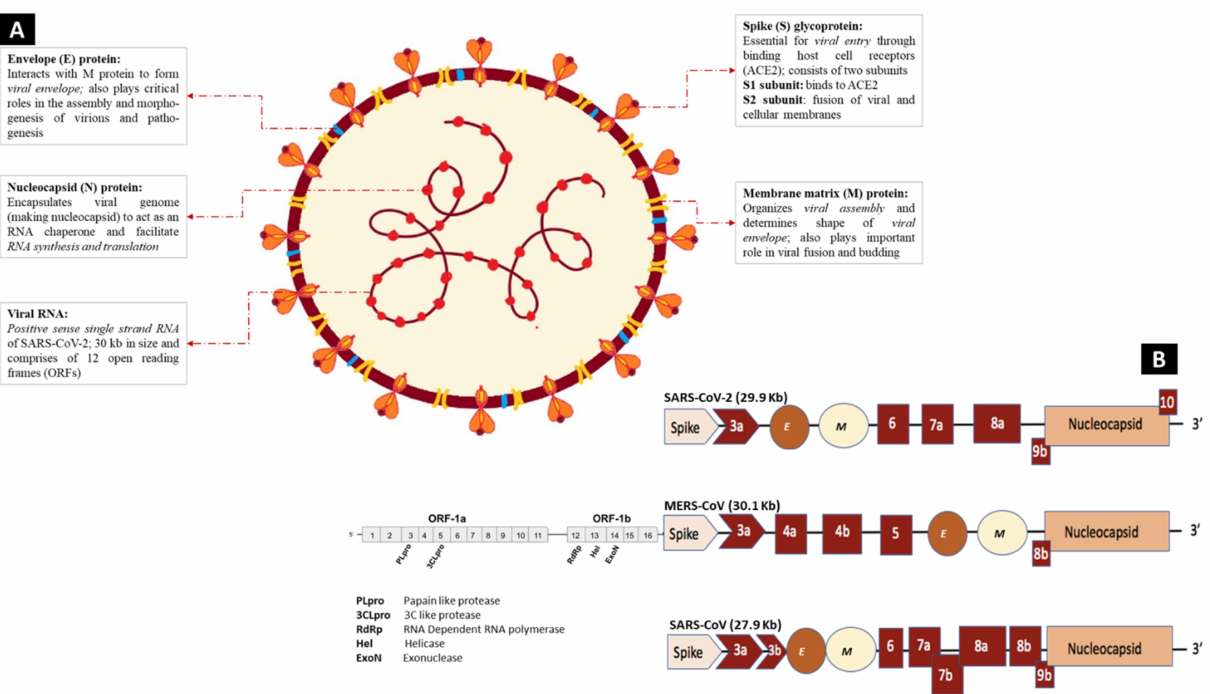
Figure 4. Schematic diagram of the SARS-CoV-2 structural and functional components. ( A ) The single-stranded viral RNA (ssRNA) is encapsulated at places with the nucleocapsid (N) protein, whereas the membrane consists of both the membrane matrix (M) and the envelope (E) proteins, from where the spike (S) protein protrudes outside and interacts with human ACE2 receptors during viral entry. ( B ) Consisting of two open reading frames (ORFs), ORF 1a and 1b, that code for Non-structural proteins (NSPs) as well as PLpro, 3CLpro, RdRp, exonuclease, the 29.9 kb ssRNA genome of SARS-CoV-2 observes similarities with the genomes of previous epidemic-causing coronaviruses, namely MERS-CoV (30.1 kb) and SARS-CoV (27.9 kb). In addition to coding for the polyproteins pp1a and pp1ab, the genome is responsible for translating numerous structural and functional molecules such as the S protein, E protein, M protein, and N